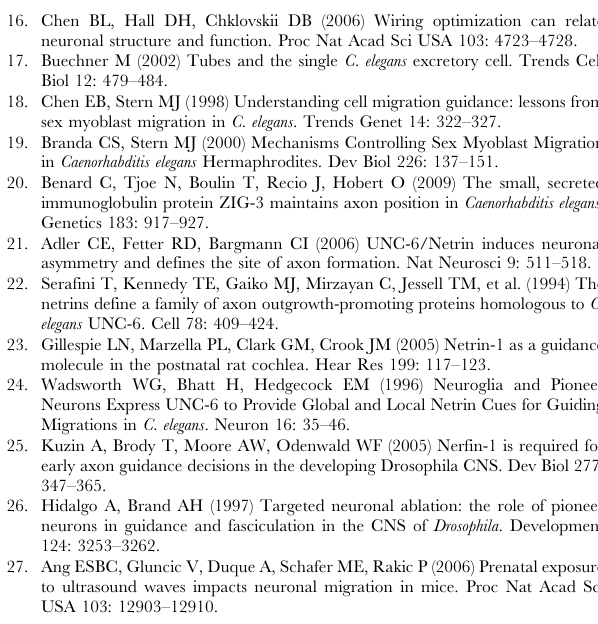
Figure S1 Neurons formed at successive stages of growth. Neuron positions are shown at the adult stage (orientations are along the Anterior (A)-Posterior (P), and Dorsal (D)-Ventral (V) axes). Note that some ventral cord neurons are established early whereas most occur at late stages of development. Figure S2 Growth pattern of sensory, motor and inter neurons. The vertical dashed line indicates the approximate time of hatching. The plot shows the percentage of neurons formed at each time step for the three neurons types (sensory, inter, and motor neurons). Note that while sensory and inter-neurons are formed early on, less than fifty percent of the motor neurons are formed at the time of hatching (800 minutes). By excluding poly- modal neurons, the percentage drops further to around 30%. Figure S3 Distribution of approximated metric connection lengths during development as a reflection of neuron births. The metric lengths correspond to the adult and the presence at a